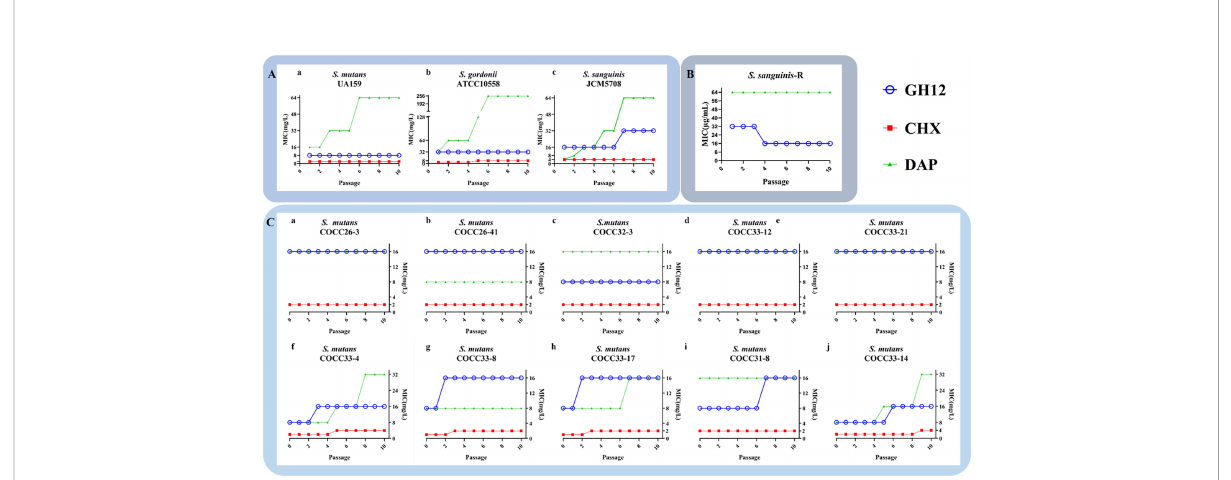
FIGURE 1 (A) MICs of GH12, CHX and DAP against S. mutans UA159 (a) , S. gordonii ATCC10558 (b) and S. sanguinis JCM5708 (c) from passages 1 to 10. (B) Evaluation of the stability of acquired resistance of S. sanguinis -R strain. S. sanguinis -R: resistant S. sanguinis strain toward GH12 and DAP. (C) MICs of GH12, CHX and DAP against S. mutans clinical strains (passage 0) and MICs after each passage under exposure to sub-MIC concentration (passage 1 to 10). The data are represented as mean ± standard deviation